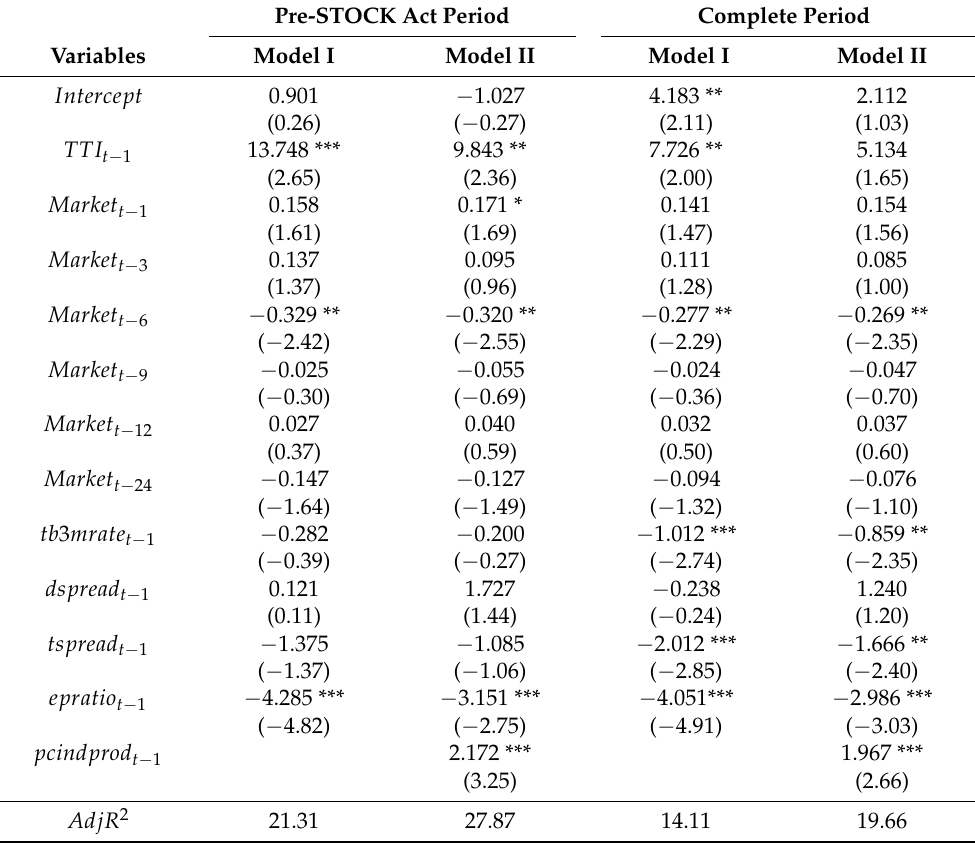
Table 3. Transactions-based trading index and equal-weighted market